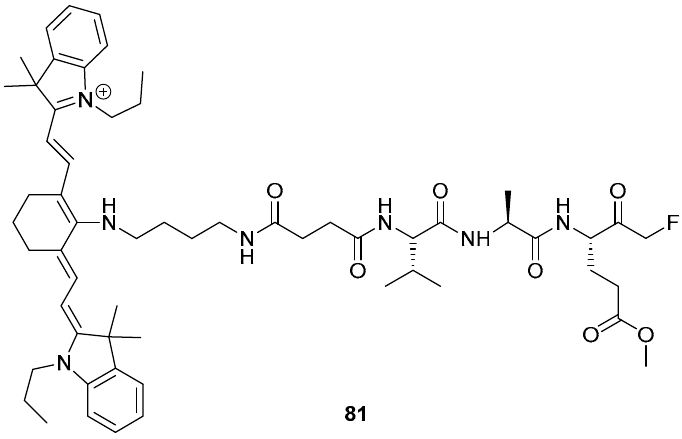
Figure 5. Structure of IR780-linker-Val-Ala-Glu(OMe)-FMK ( 81 ) [7].